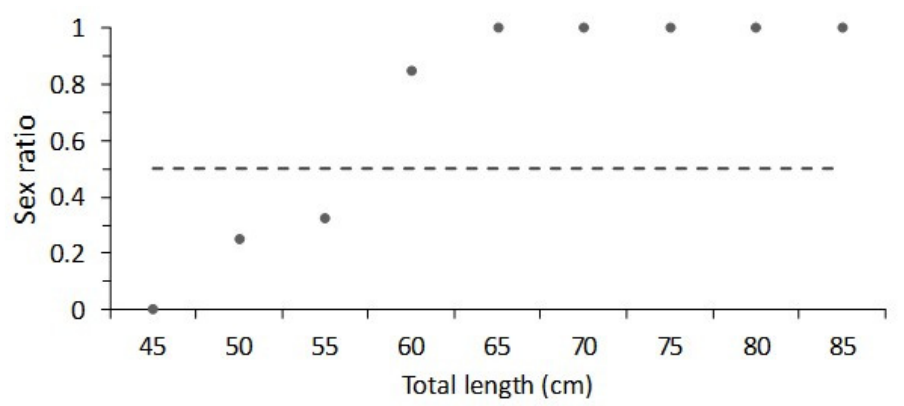
Figure 1. Sex ratio female:male (F:M) of giant electric rays, Narcine entemedor , by size intervals.